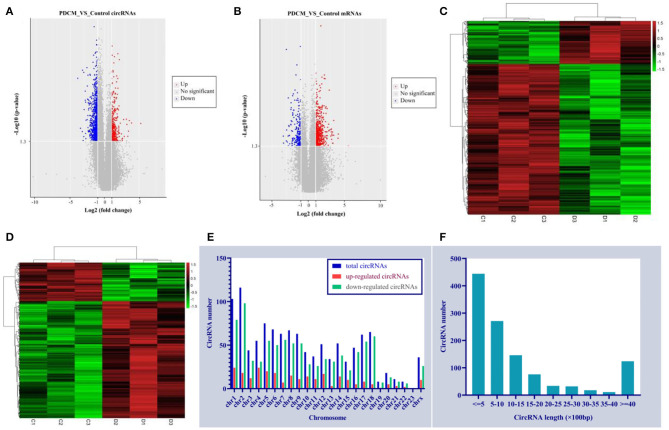
Circulating expression levels of circRNAs and mRNA in the pediatric dilated cardiomyopathy group and control group. (A) A volcano plot of differential circRNA expression with various p-values and fold changes. (B) A volcano plot of differential mRNA expression with various p-values and fold changes. (C) Hierarchical clustering analysis of circRNAs with altered expression (p < 0.05, fold change >2) between the two groups. Red strip, high relative expression; green strip, low relative expression; black strip, no change. Color brightness reflects the degree of expression increase or decrease. (D) Hierarchical clustering analysis of mRNAs with altered expression (p < 0.05, fold change >2) between the two groups. Red strip, high-relative expression; green strip, low-relative expression; black strip, no-change. Color brightness reflects the degree of expression increase or decrease. (E) The dysregulated circRNA distribution rule in human chromosomes. (F) Length distribution of the dysregulated circRNAs.